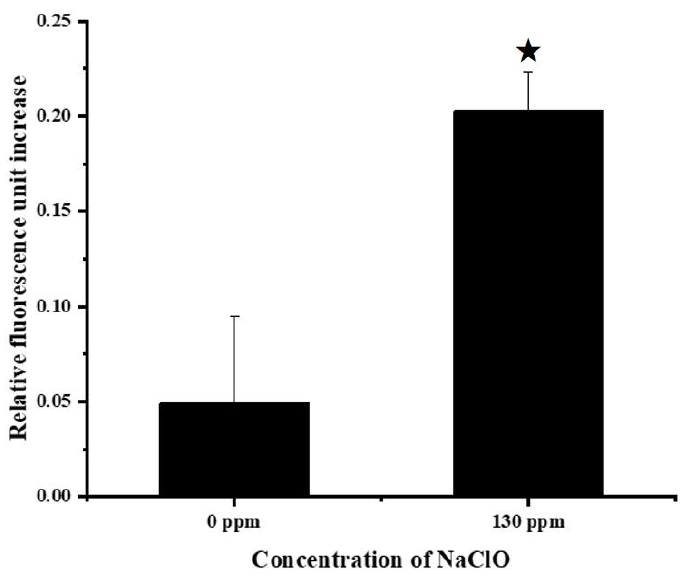
Figure 2. Changes in ROS generation in S . Enteritidis in response to 130 ppm sodium hypochlorite. Asterisk indicates a significant difference ( p < 0.05).